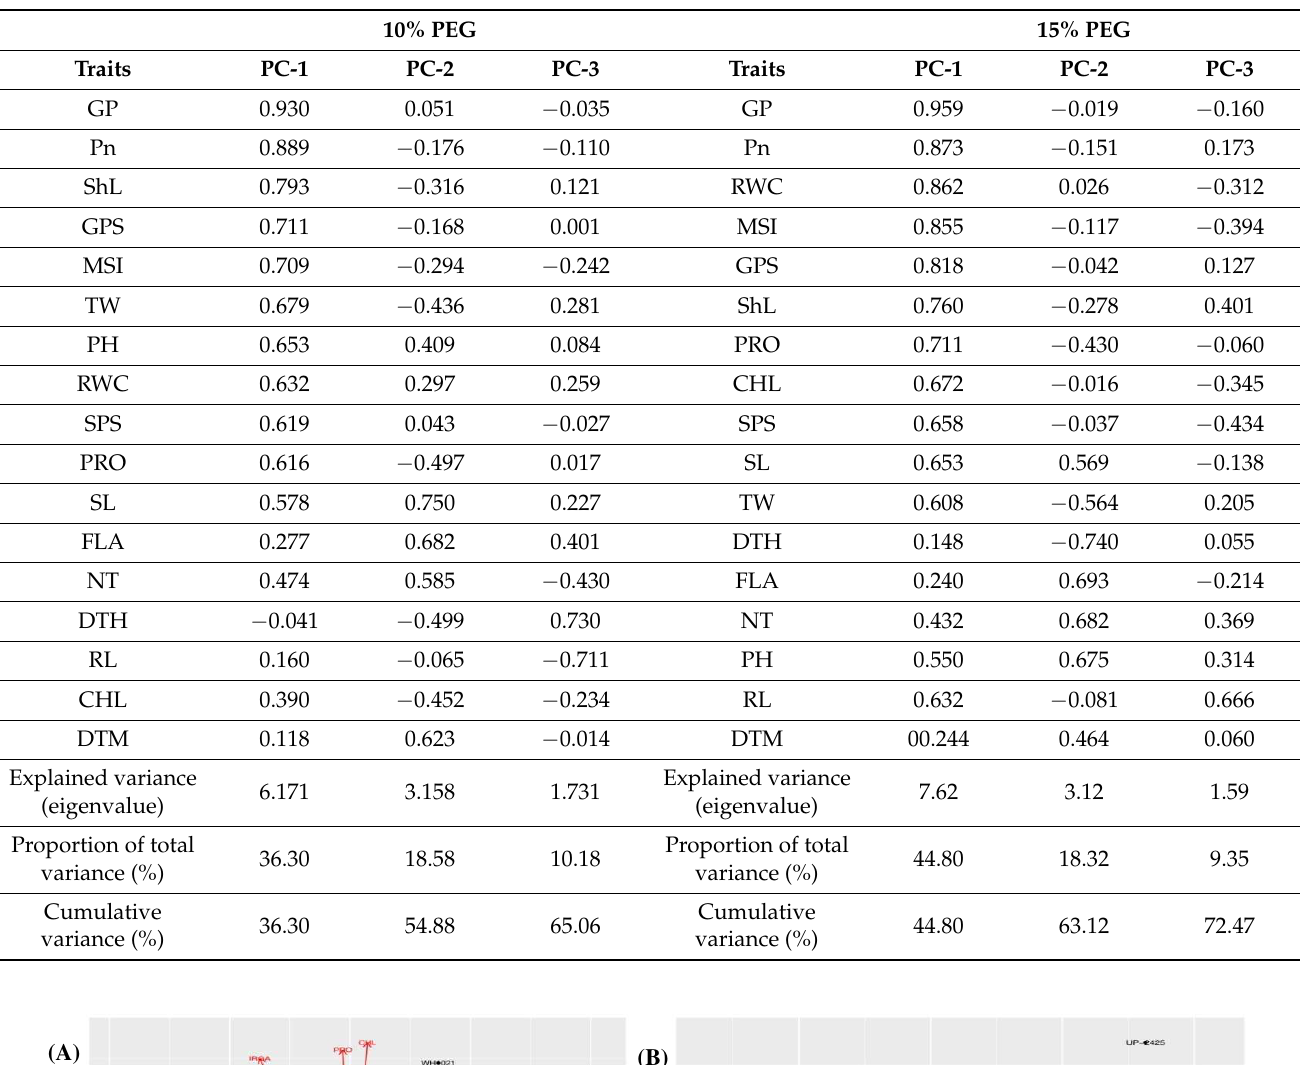
Table 8. Rotated component matrix of morphological, physiochemical, and biochemical traits of 15 wheat genotypes under 10% PEG and 10%PEG treatment conditions. Abbreviations: see Table 5.